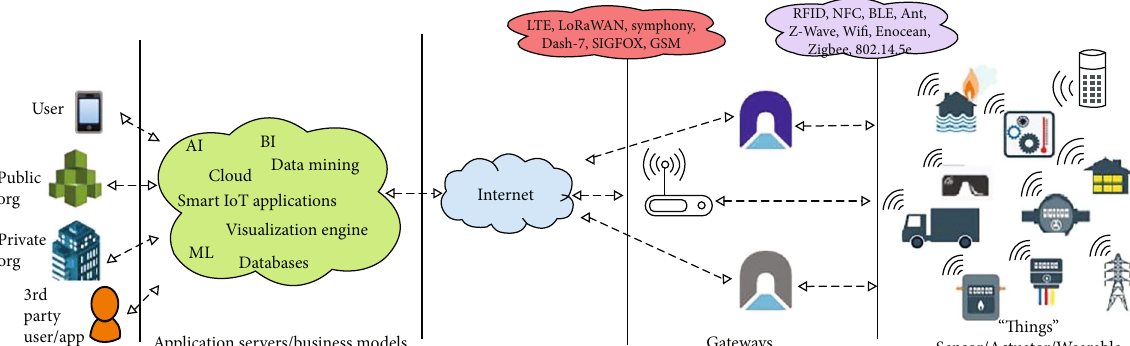
Figure 1: Generic IoT architecture